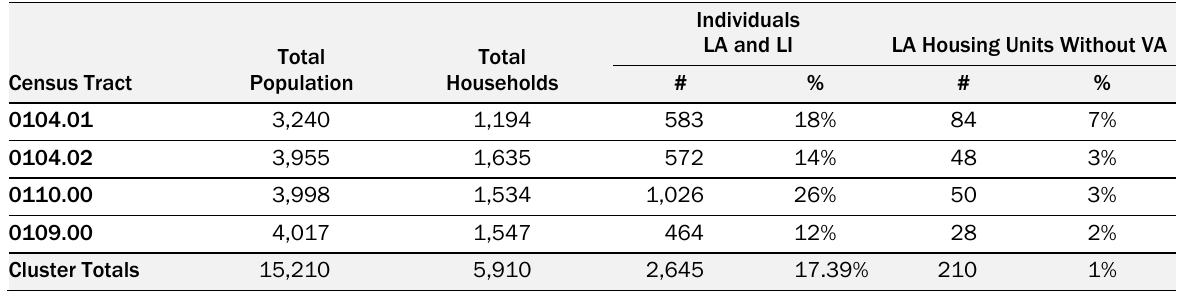
Table 1. Selected Population Characteristics for Identified Food Desert Cluster in Duval County, Florida, Including Total Population and Number of Households, Number and Proportion of Individuals Experiencing Low Access (LA) And Low Income (LI) and the Number and Proportion Also Without Vehicle Access